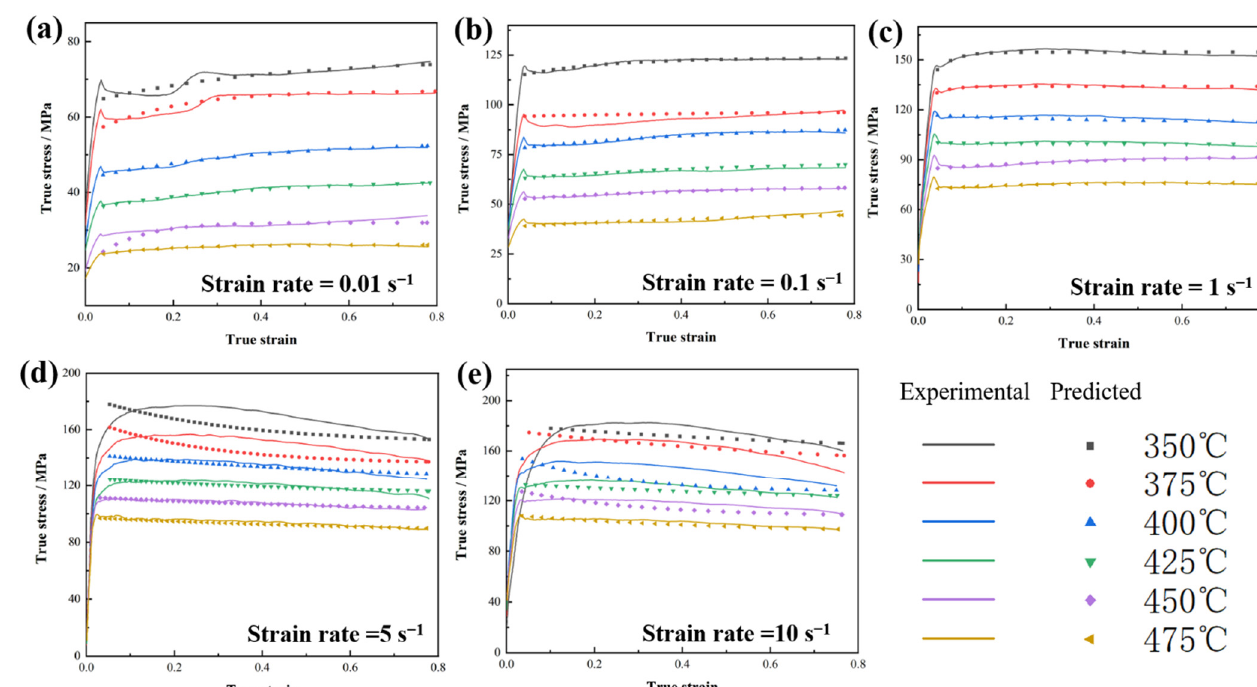
Figure 14. Prediction results of the VOCE model with various deformation parameters. ( a ) strain rate = 0.01 s − 1 ; ( b ) strain rate = 0.1 s − 1 ; ( c ) strain rate = 1 s − 1 ; ( d ) strain rate = 5 s − 1 ; ( e ) strain rate = 10 s − 1